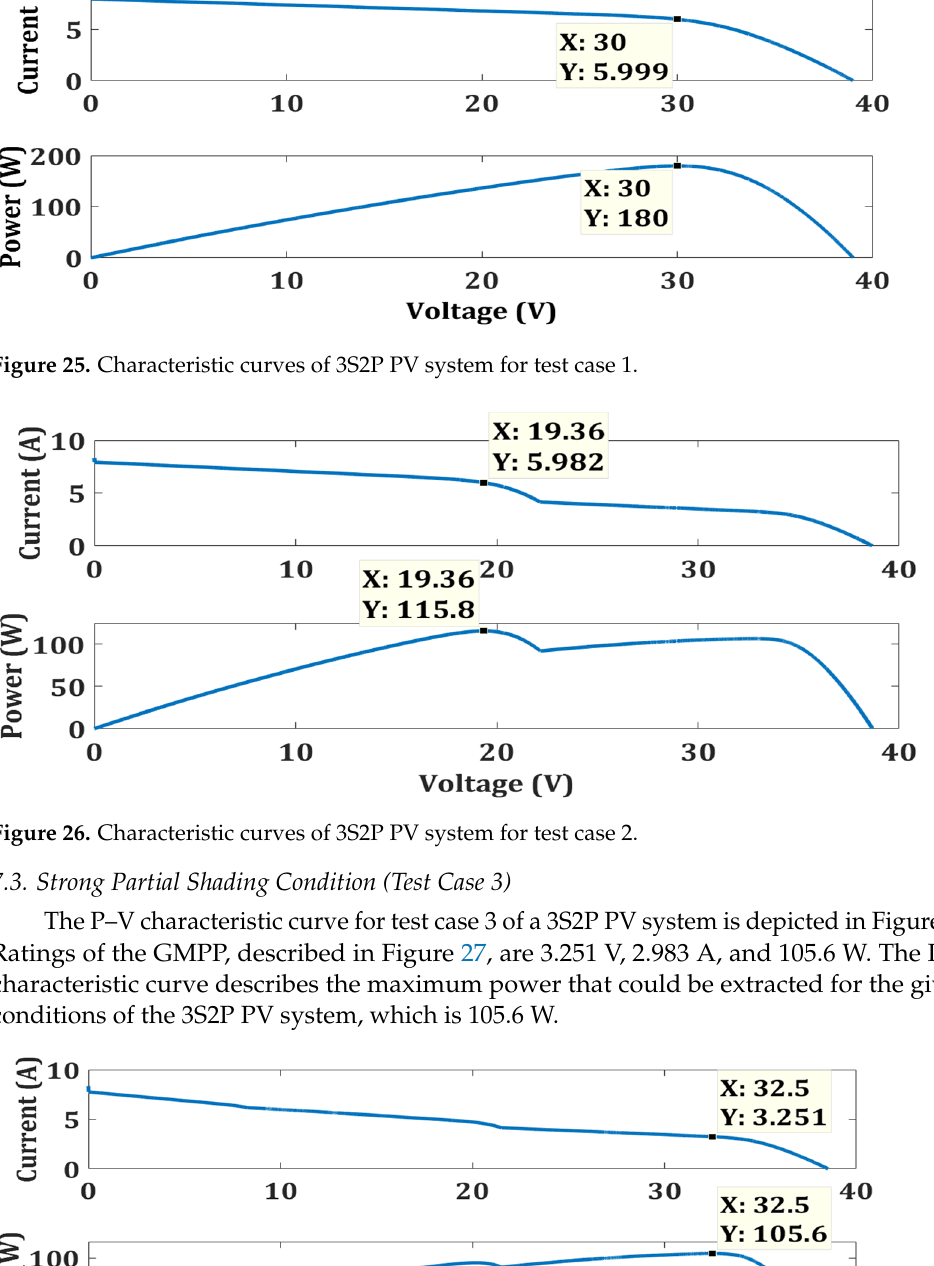
Figure 27. Characteristic curve of 3S2P PV system for test case 3 .